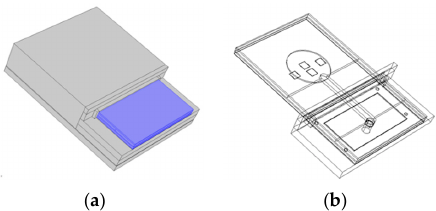
Figure 2. The simplified model geometry: ( a ) LTCC sensor placed in the inner part of the sensor-in-housing assembly with visible sensor part (colored blue); ( b ) wireframe view.